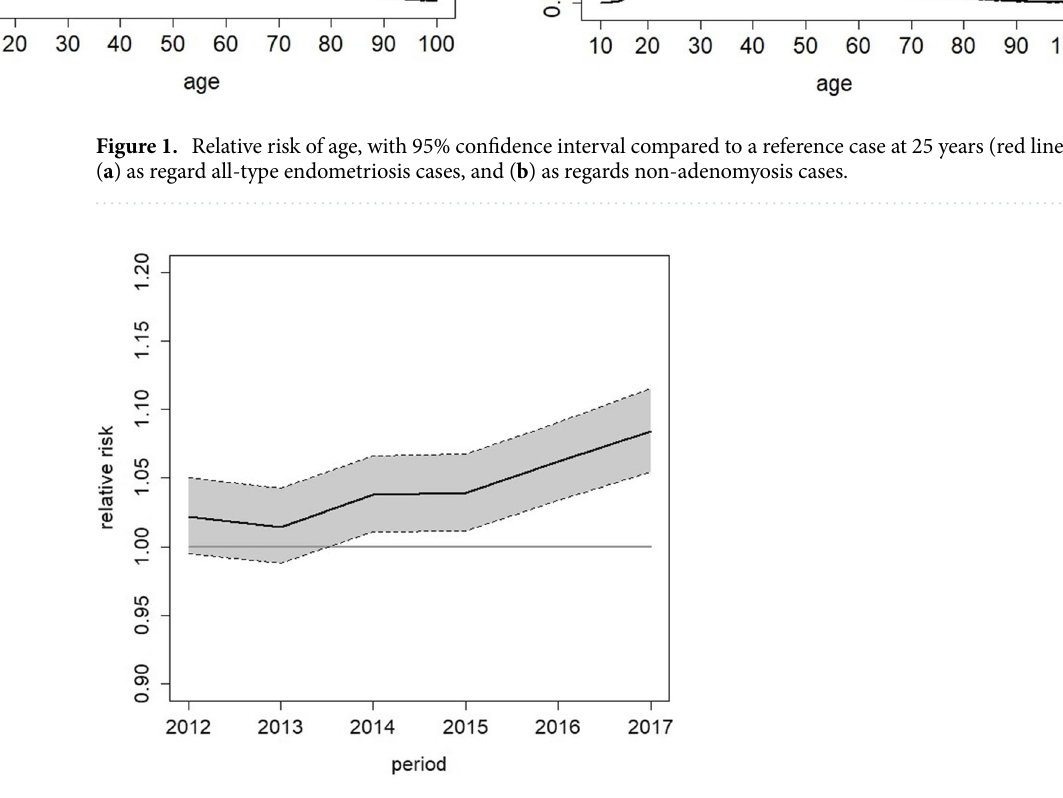
Figure 2. Temporal trend of the risk of all-type hospitalized cases in the whole of France in females aged 10 years and above: relative risk and its 95% confidence interval (Knorr-Held